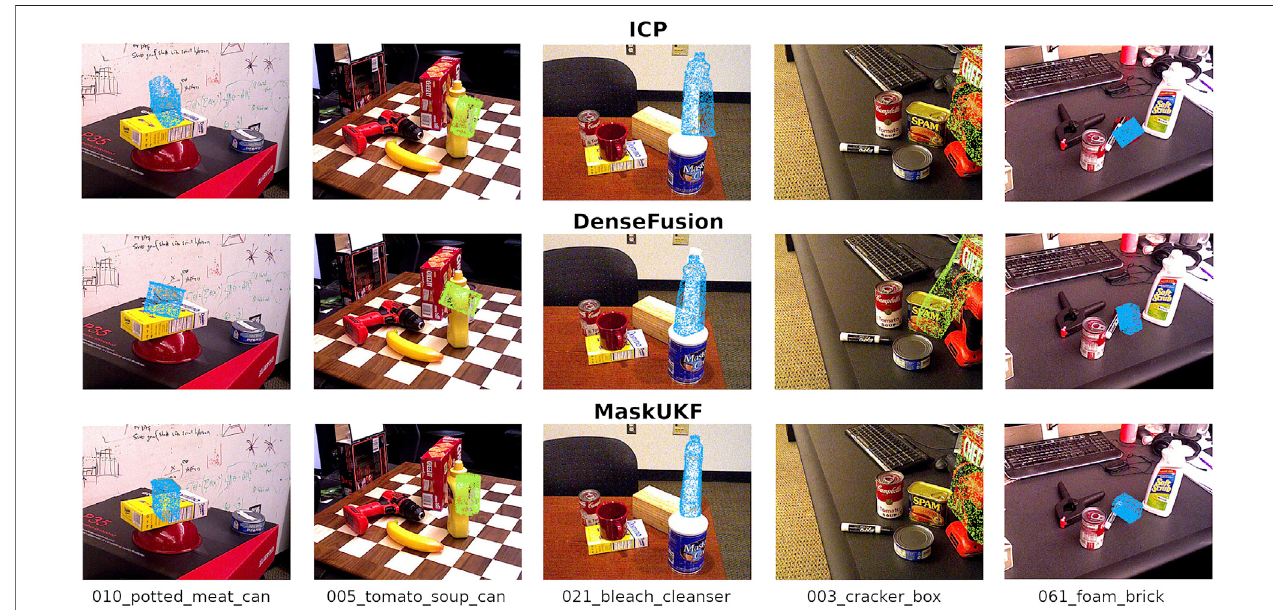
FIGURE 3 | Qualitative results on the YCB Video Dataset. All the results reported here are obtained using the segmentation masks from PoseCNN. The estimated pose is represented as a coloured point cloud transformed in the estimated pose and projected to the 2D RGB frame.